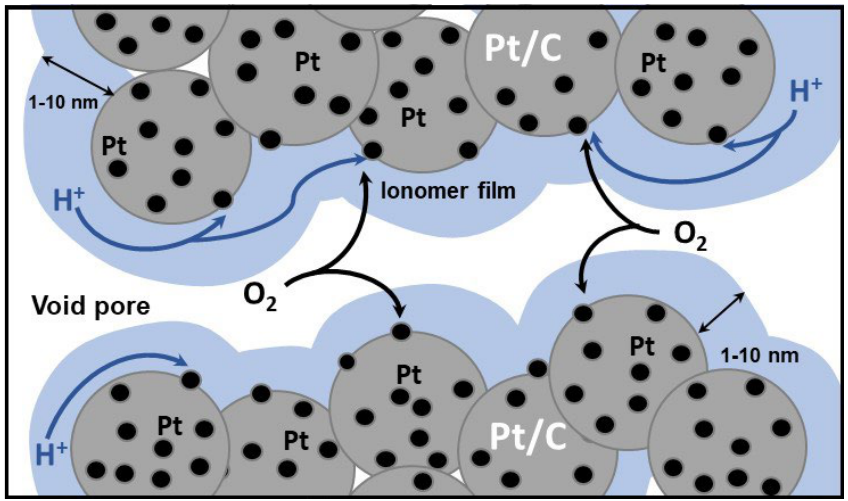
Figure 1. Schematic of the cathode catalyst layer structure in PEM fuel cells. Pt/C agglomerates are covered by a thin ionomer film. To reach Pt sites, oxygen transported along the void pore must penetrate through the ionomer.